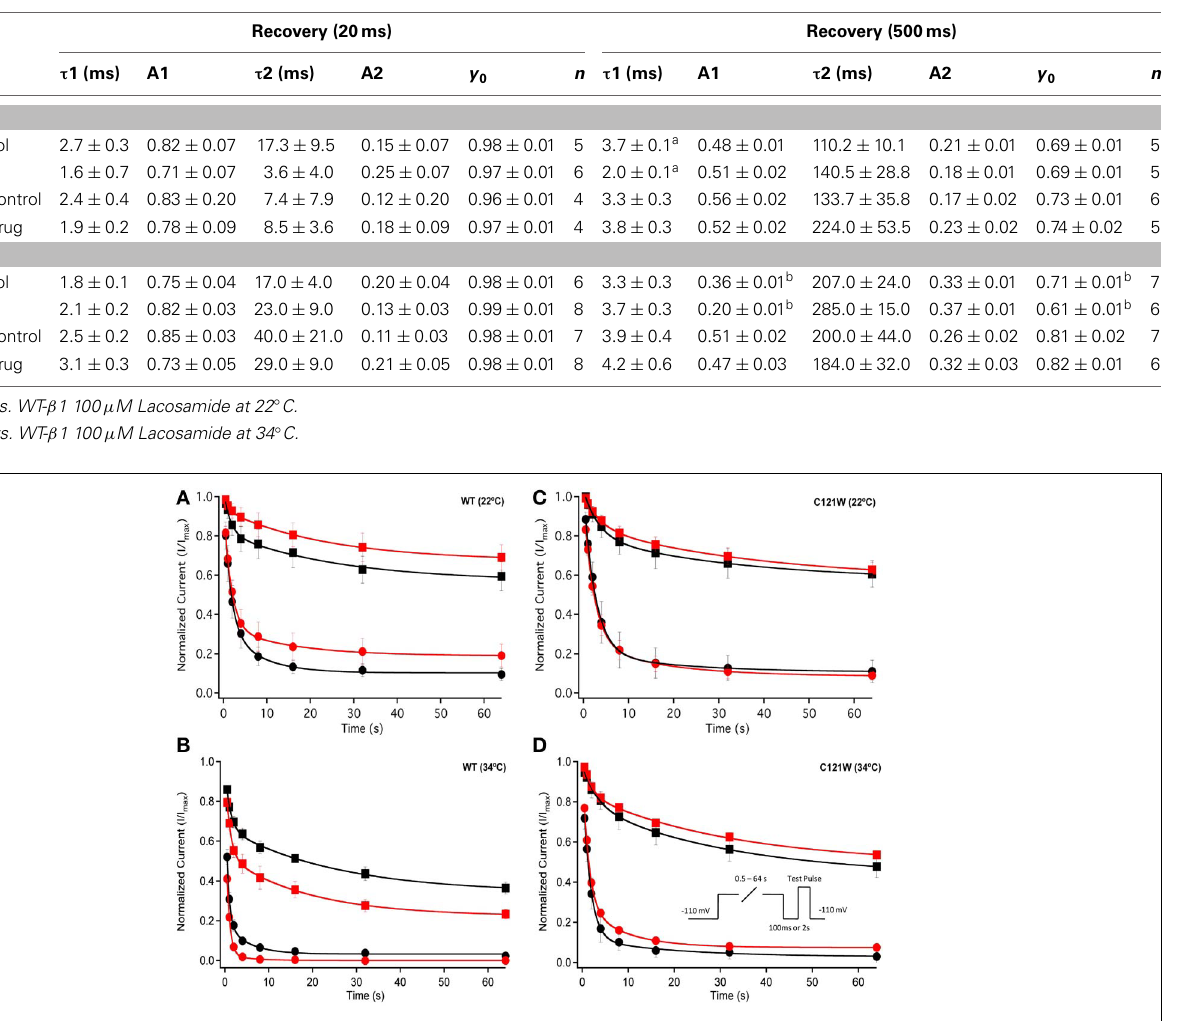
FIGURE 4 | Slow inactivation onset. Normalized Current is plotted against a range of onset durations (s). We show two different recovery pulse durations: 100ms (filled squares) and 2s (filled circles) in control